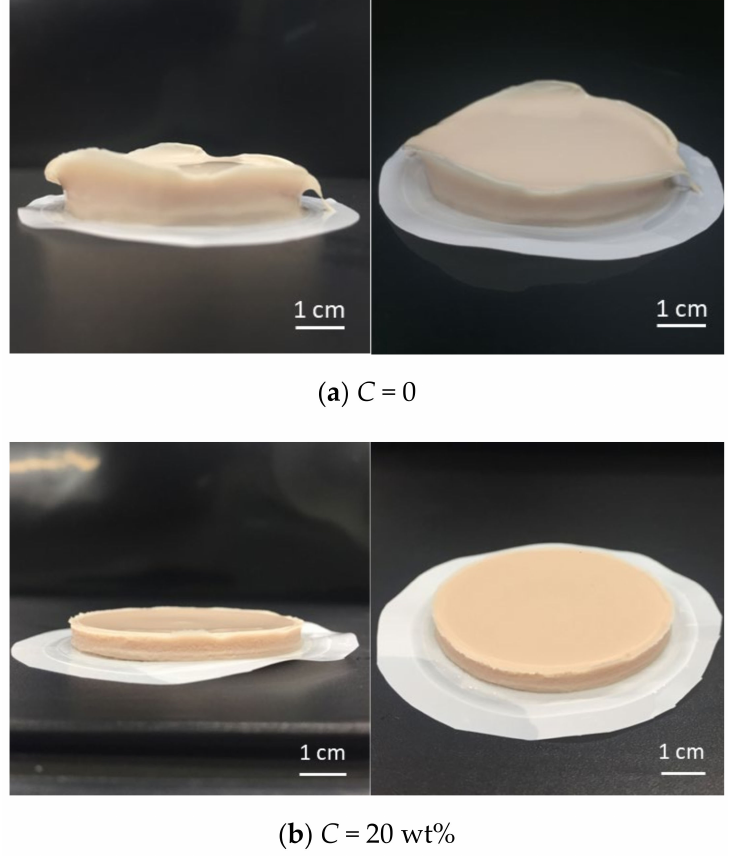
Figure 5. Photo of filter cake ( s c = 0.078, p = 50 kPa): ( a ) C = 0; ( b ) C = 20 wt%.